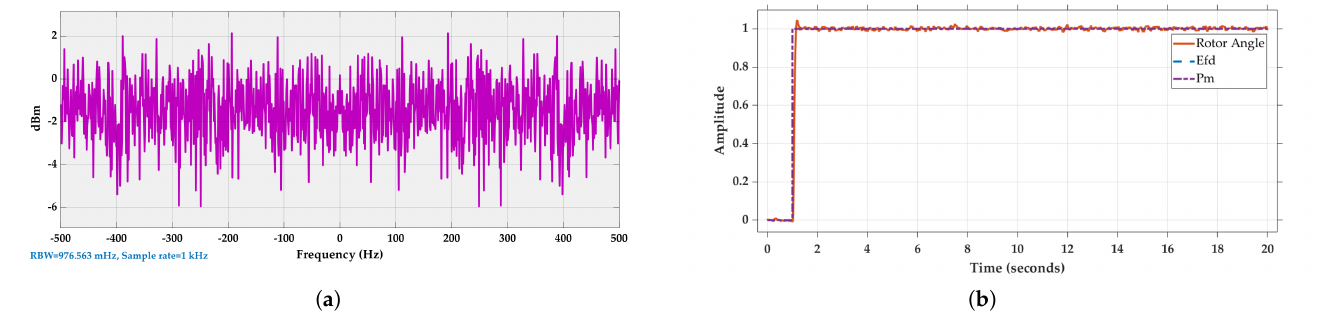
Figure 7. Synchronous generator subjected to Gaussian noise. ( a ) Gaussian noise characteristics; ( b ) rotor angle when E FD = 1, P m = 1, and learning rate = 10.